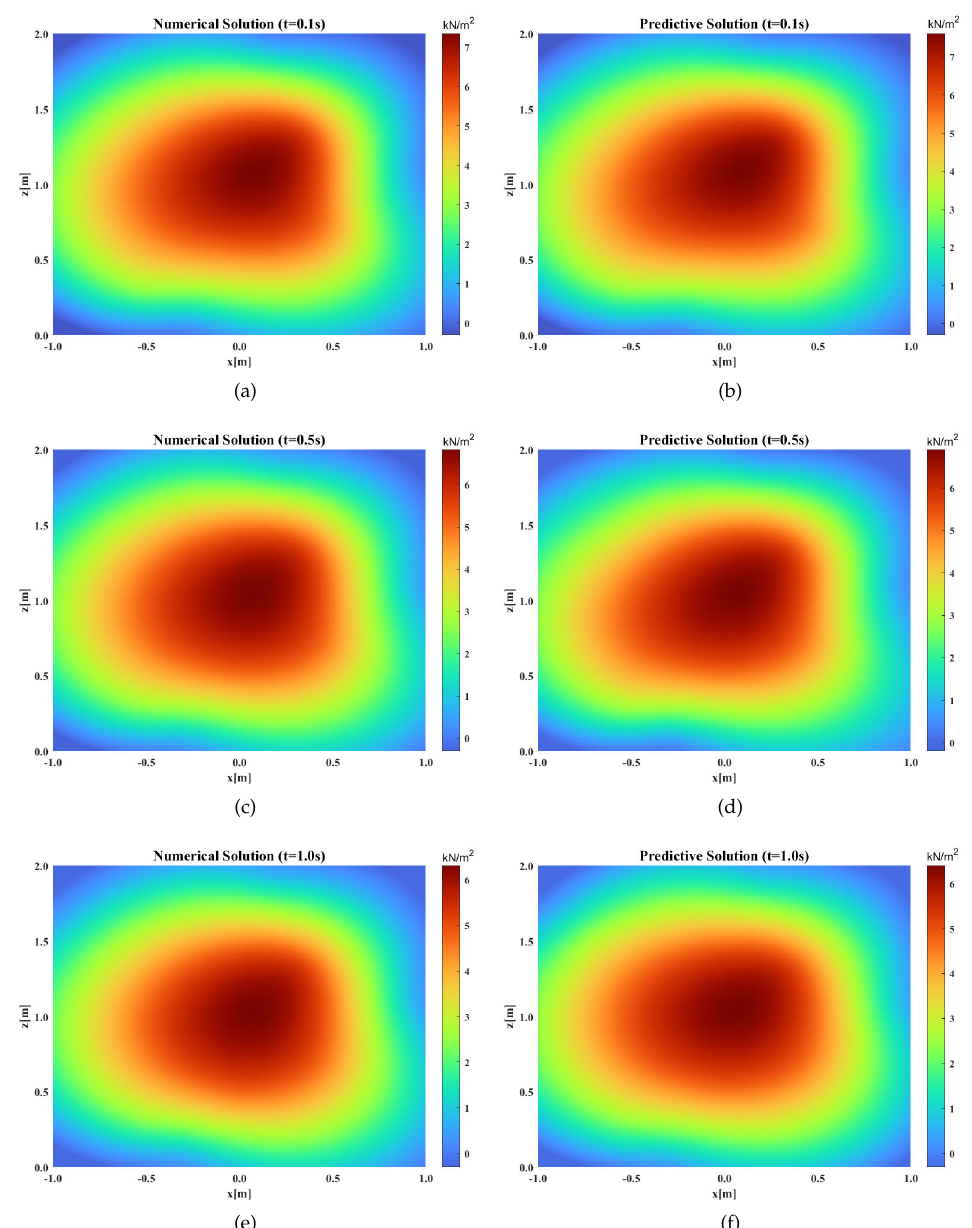
Figure 10. Color maps for numerical solution and predicted solution of two-dimensional soil con- solidation for drainage at the top and bottom boundaries at different times. ( a ) Numerical solution (t = 0.1 s); ( b ) Predictive solution (t = 0.1 s); ( c ) Numerical solution (t = 0.5 s); ( d ) Predictive solution (t = 0.5 s); ( e ) Numerical solution (t = 1.0 s); ( f ) Predictive solution (t = 1.0